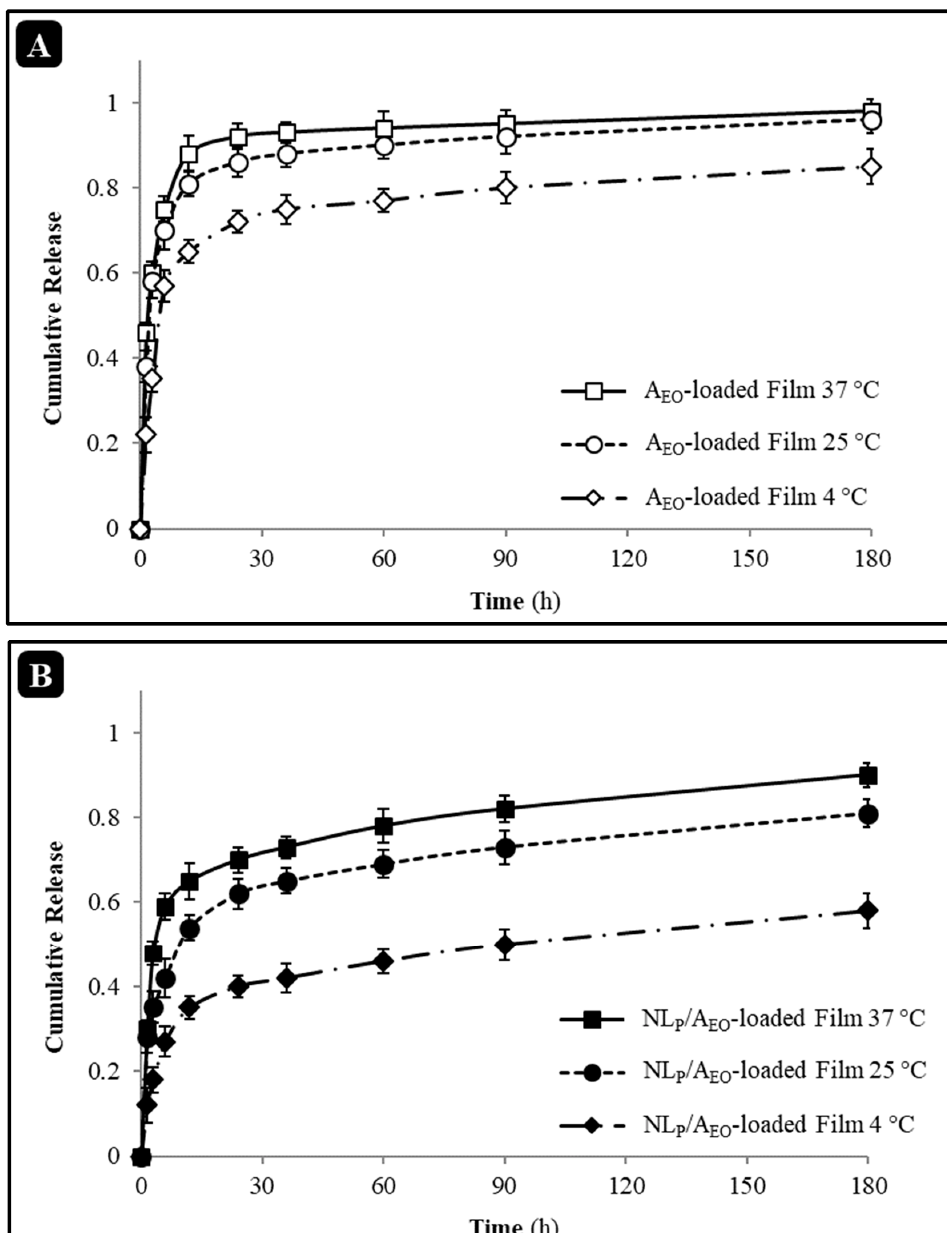
Figure 5. Effects of different temperatures on in vitro release profile of free A EO ( A , B ) NL P /A EO - loaded Salep mucilage films. loaded Salep mucilage